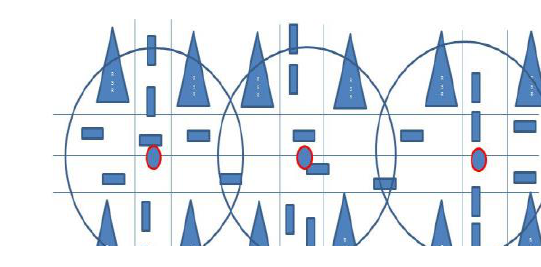
Figure 2: System architecture